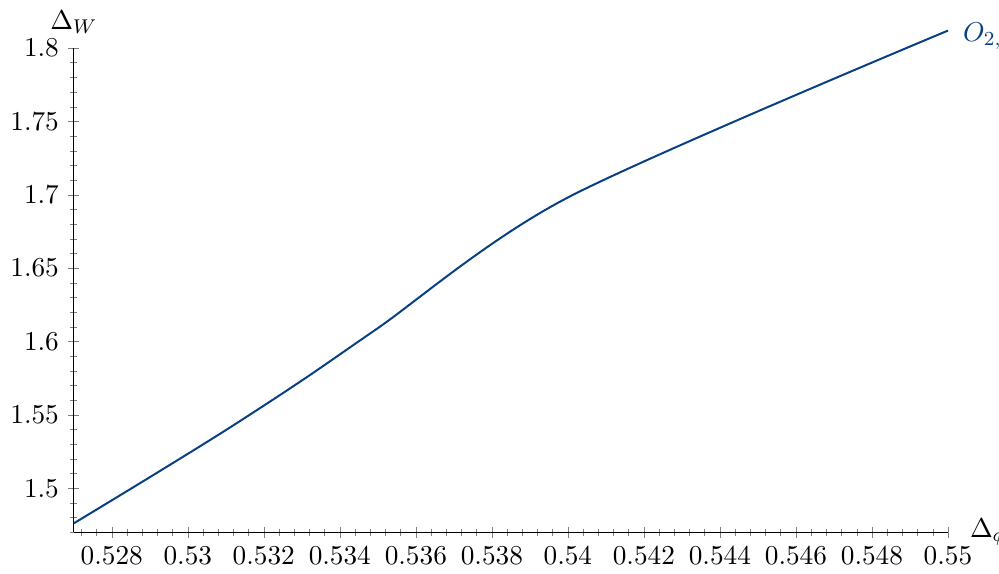
Figure 10: Upper bound on the dimension of the first scalar W operator in the φ × φ OPE as a function of the dimension of φ . The area above the curve is ar bs